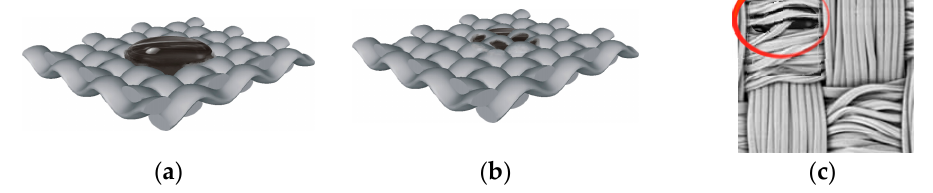
Figure 1. Levels of interaction between contamination and woven fabric. ( a ) Surface adhesion of contamination on the fabric; ( b ) liquid contamination penetration into the fabric structure; ( c ) liquid contamination penetration into the structure of the yarn.